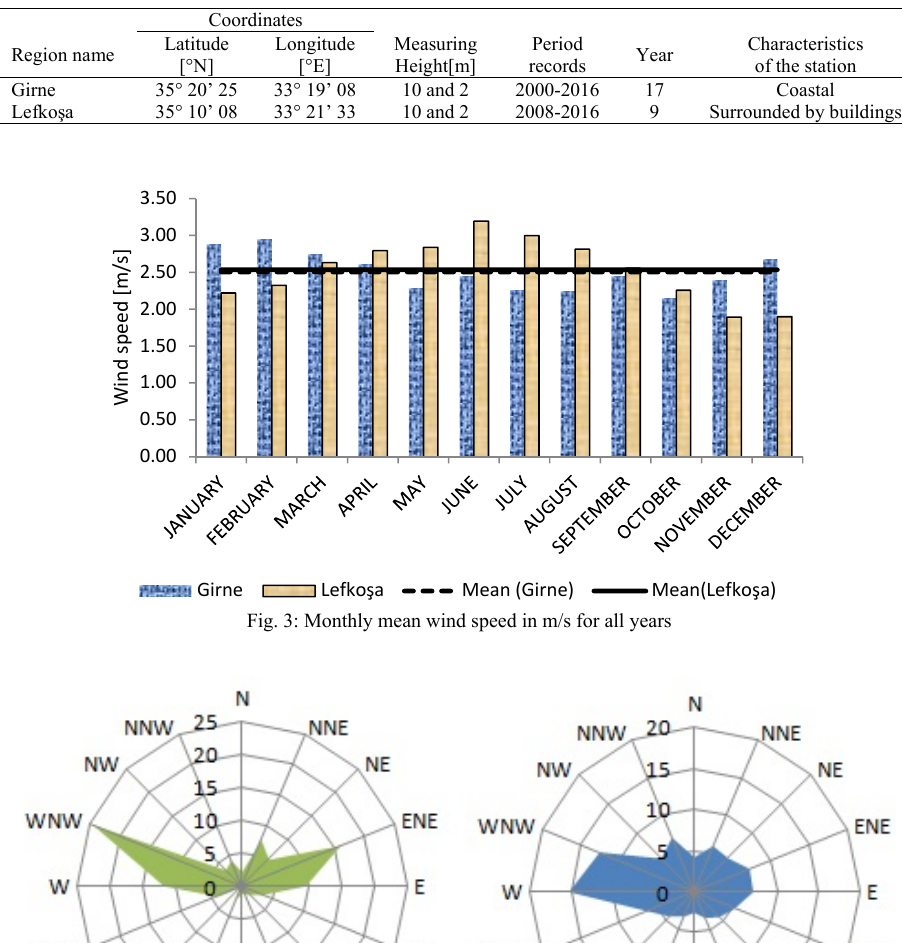
Table 2: Details of each station used in the analysis